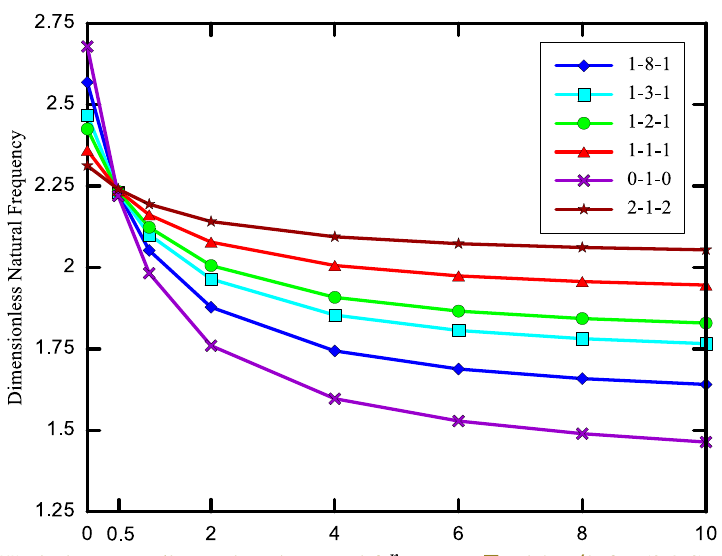
Fig. 7. Variation of non-dimensional natural frequency 𝛚̅ with nx for (1-8-1) sandwich plate with different boundary conditions.